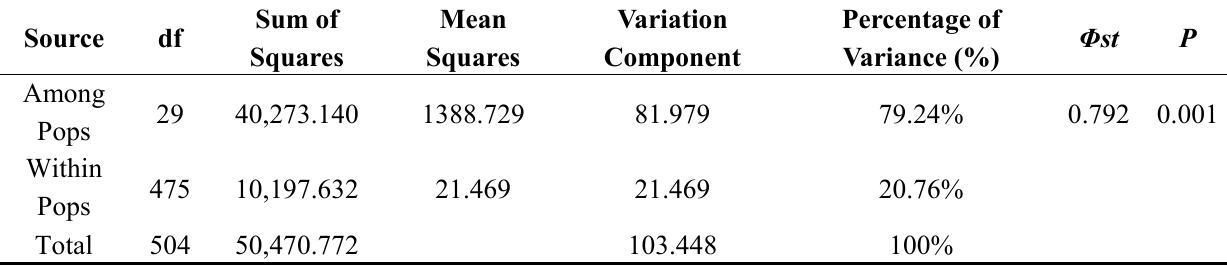
Figure 4. Clustering results of 30 T. ciliata populations using STRUCTURE. Table 5. Analysis of molecular variance (AMOVA) of 30 T. ciliata